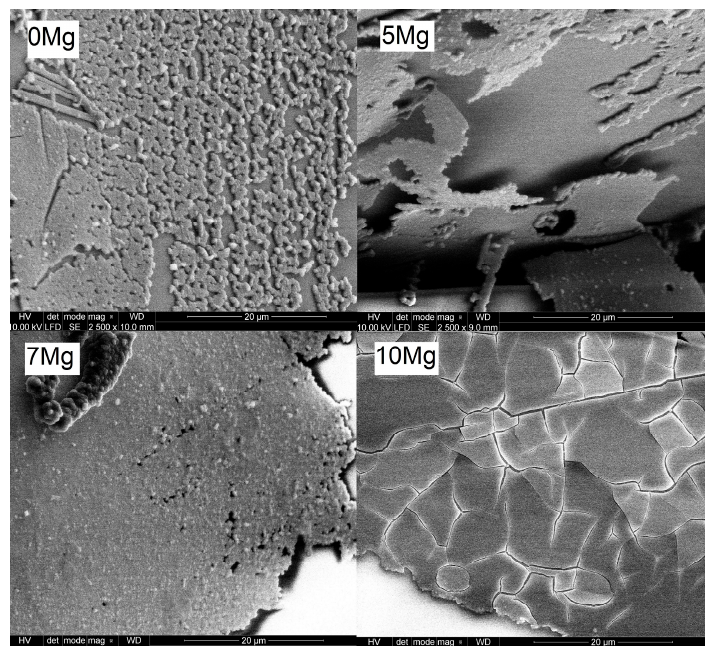
Figure 9. SEM micrographs after 15 days of incubation in the PBS for all glasses.